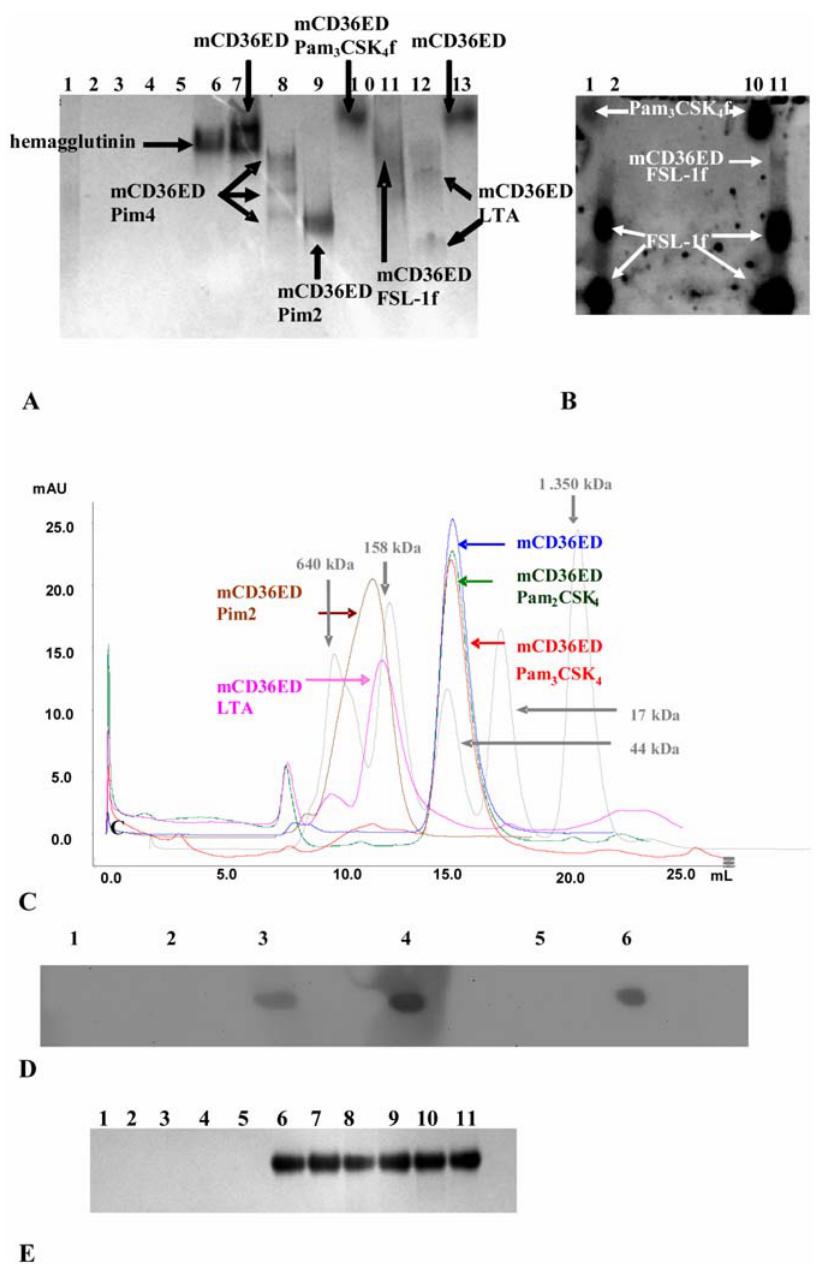
Figure 2. mCD36ED binds to FSL-1, Pim2, LTA and Pim4, but not to Pam 3 CSK 4 . mCD36ED was incubated overnight with TLR2 ligands or influenza hemagglutinin (H5N1 Viet 04 strain) and subsequently run on a native 4–20% PAGE for 4 hours at 100 volts. Fluorescence was determined with a Versadoc imaging system. Subsequently, the gel was stained with Coomassie Blue. ( A ) Native gel stained with Coomassie Blue. ( B ) Fluorescence from the native gel determined using a Versadoc imaging system. Lanes: 1- 1 m g of Pam 3 CSK 4 - fluorescein (Pam 3 CSK 4 f) ; 2- 1 m g of FSL- 1-fluorescein (FSL-1f); 3- 1 m g of Pim4; 4- 1 m g of Pim2; 5- 1 m g of LTA; 6- 10 m g of hemagglutinin Viet 04; 7- 10 m g of mCD36ED incubated with 10 m g of hemagglutinin Viet 04; 8- 10 m g of mCD36ED incubated with 1 m g of Pim4; 9- 10 m g of mCD36ED incubated with 1 m g of Pim2; 10- 10 m g of mCD36ED incubated with 1 m g of Pam 3 CSK 4 f; 11- 10 m g of mCD36ED incubated with 1 m g of FSL-1f 12- 10 m g of mCD36ED incubated with 1 m g of LTA; 13- 10 m g of mCD36ED. ( C ) The retention volume of mCD36ED-LTA and mCD36ED-Pim2 is decreased as compared to uncomplexed mCD36ED. An appreciable shift in molecular weight is seen after incubation of mCD36ED with LTA or Pim2, but no shift is observed with Pam 2 CSK 4 or Pam 3 CSK 4 . Molecular weight standards were run in parallel to determine the apparent change in molecular weight of mCD36ED. ( D ) The presence of LTA in the mCD36ED-LTA size exclusion chromatography fractions was confirmed by dot blot analysis using an anti-LTA antibody. Lanes 1- PBS; 2- Pam 2 CSK 4 ; 3- anti-LTA antibody; 4- LTA; 5- mCD36ED; 6- mCD36ED- LTA. (E) KRN TCR with a C-terminal His-tag does not bind ligands of TLR2. Lanes 1- 1 m g of Pam 3 CSK 4 ; 2- 1 m g of LTA; 3- 1 m g of FSL-1, 4- 1 m g of Pim2, 5- 1 m g of Pim4, 6- 10 m g of KRN TCR; 7- 10 m g of KRN TCR incubated with 1 m g of Pam 3 CSK 4 ; 8- 10 m g of KRN TCR incubated with 1 m g of LTA, 9- 10 m g of KRN TCR incubated with 1 m g of FSL-1, 10- 10 m g of KRN TCR incubated with 1 m g of Pim2, 11- 10 m g of KRN TCR incubated with 1 m g of Pim4.